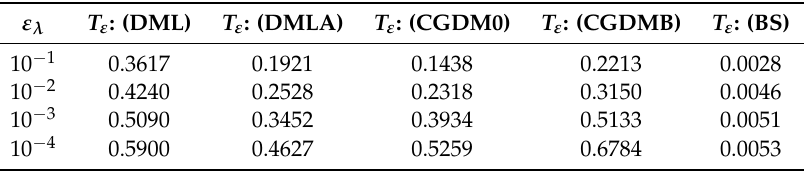
Table 16. Results for Case LG with J = 510, m =